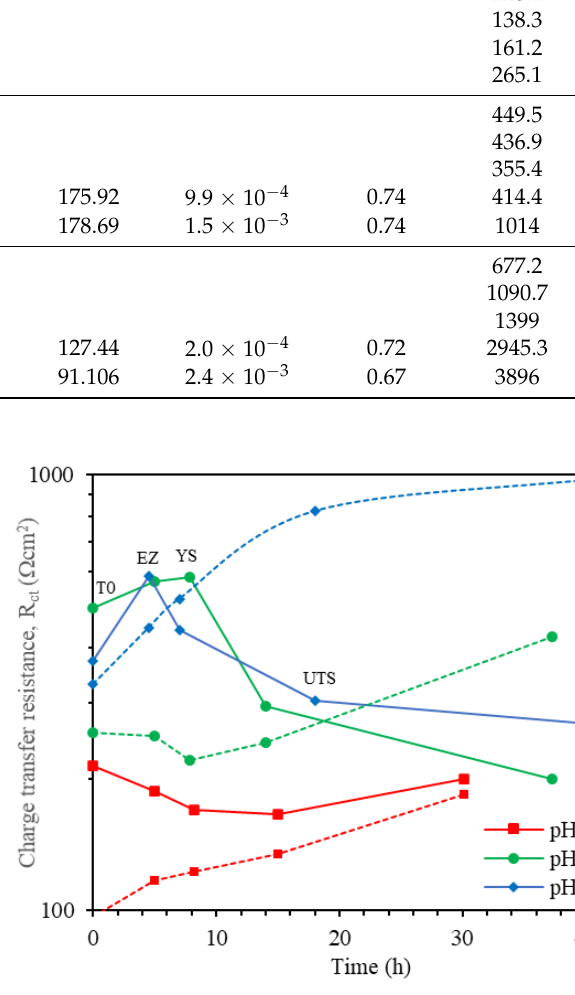
Figure 7. Charge transfer resistance, R ct (solid lines) and double layer capacitance, C dl (dashed lines) values for X70 steel exposed to NS4 solution at different pH values during SSRT test.